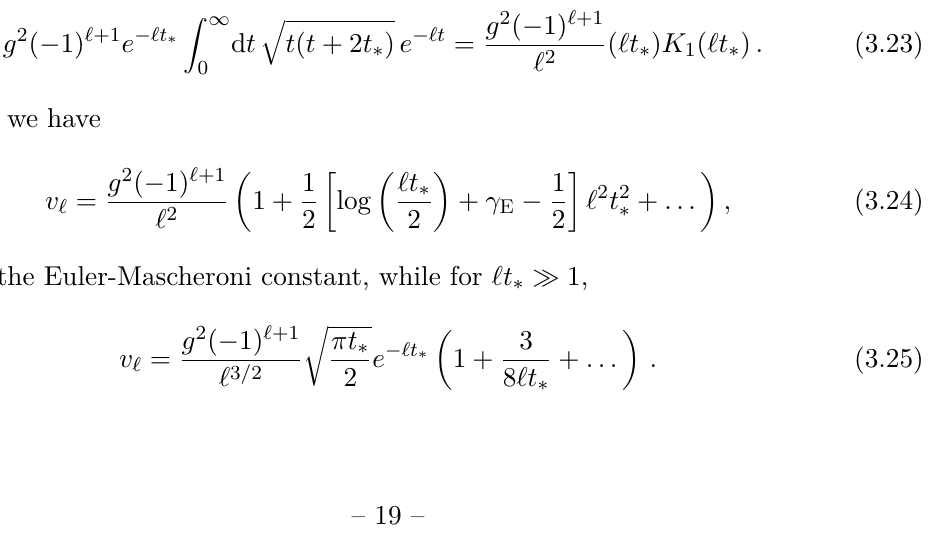
at moderate λ 1